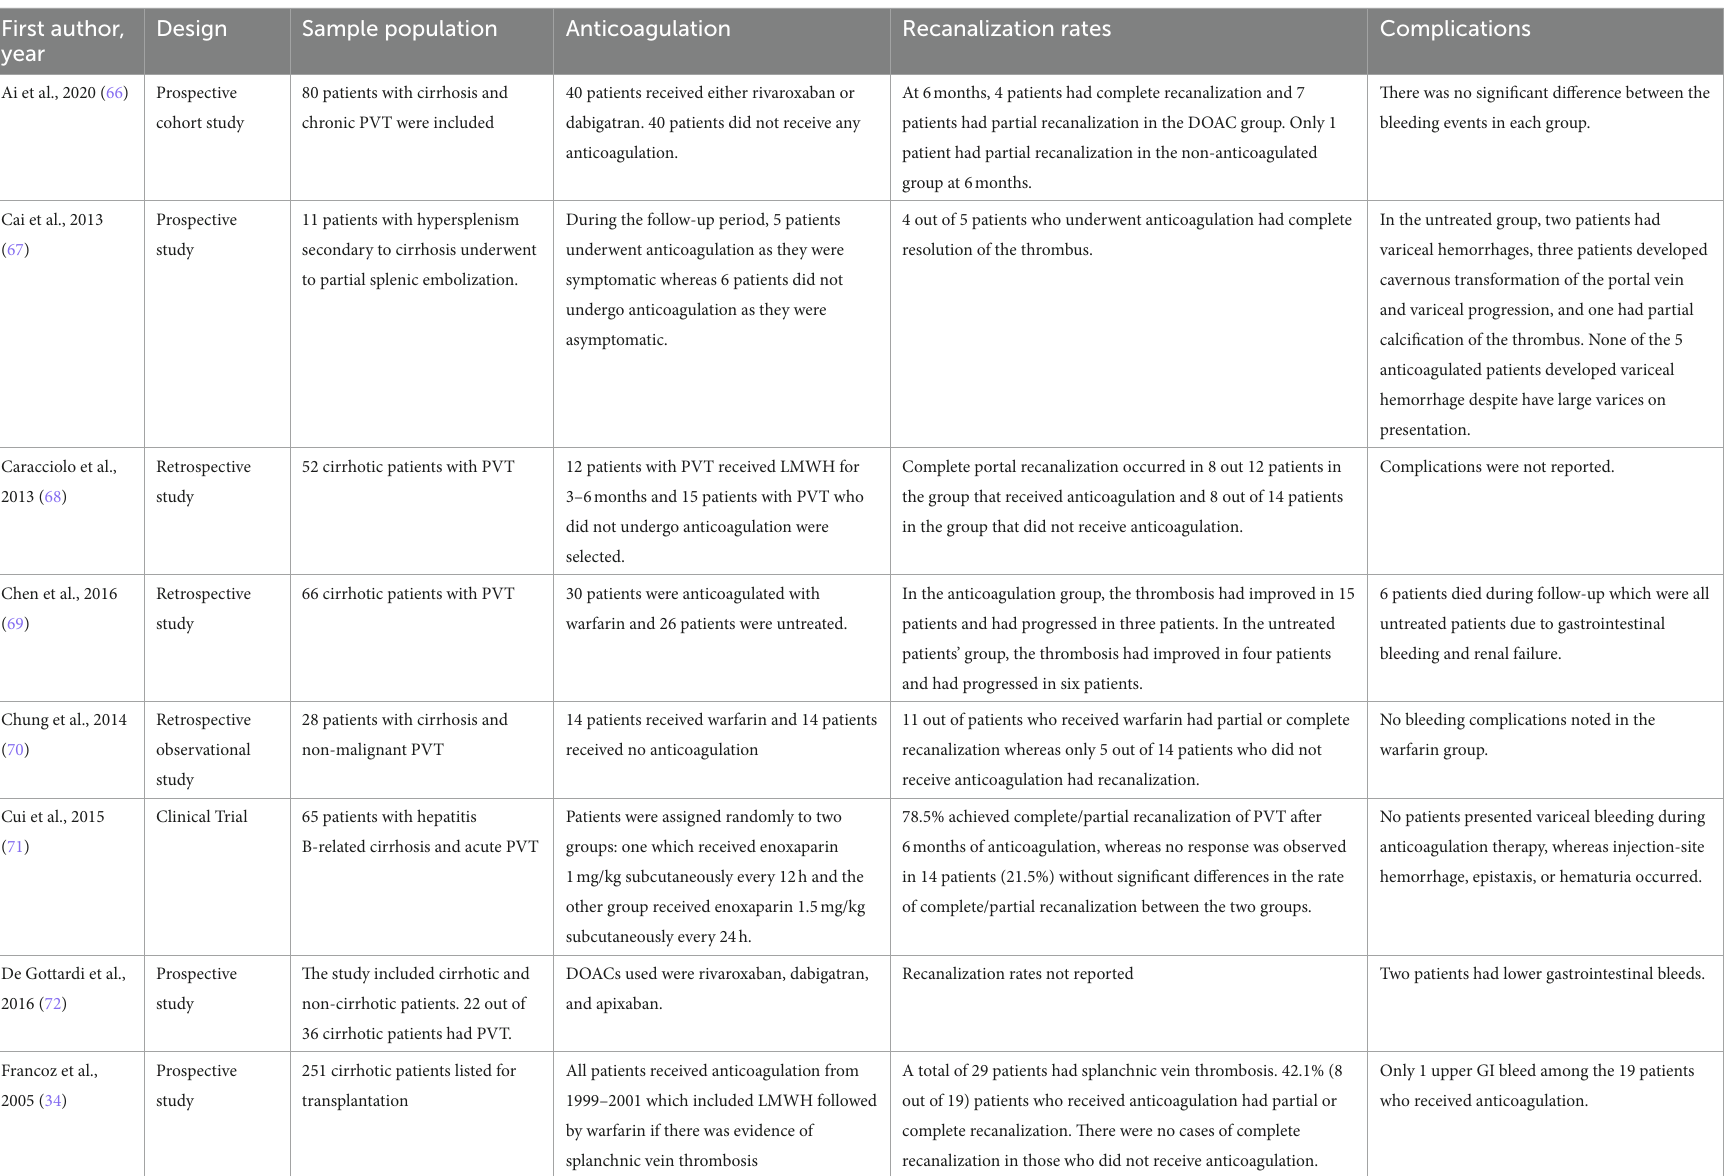
TABLE 1 Studies of portal vein thrombosis treated with